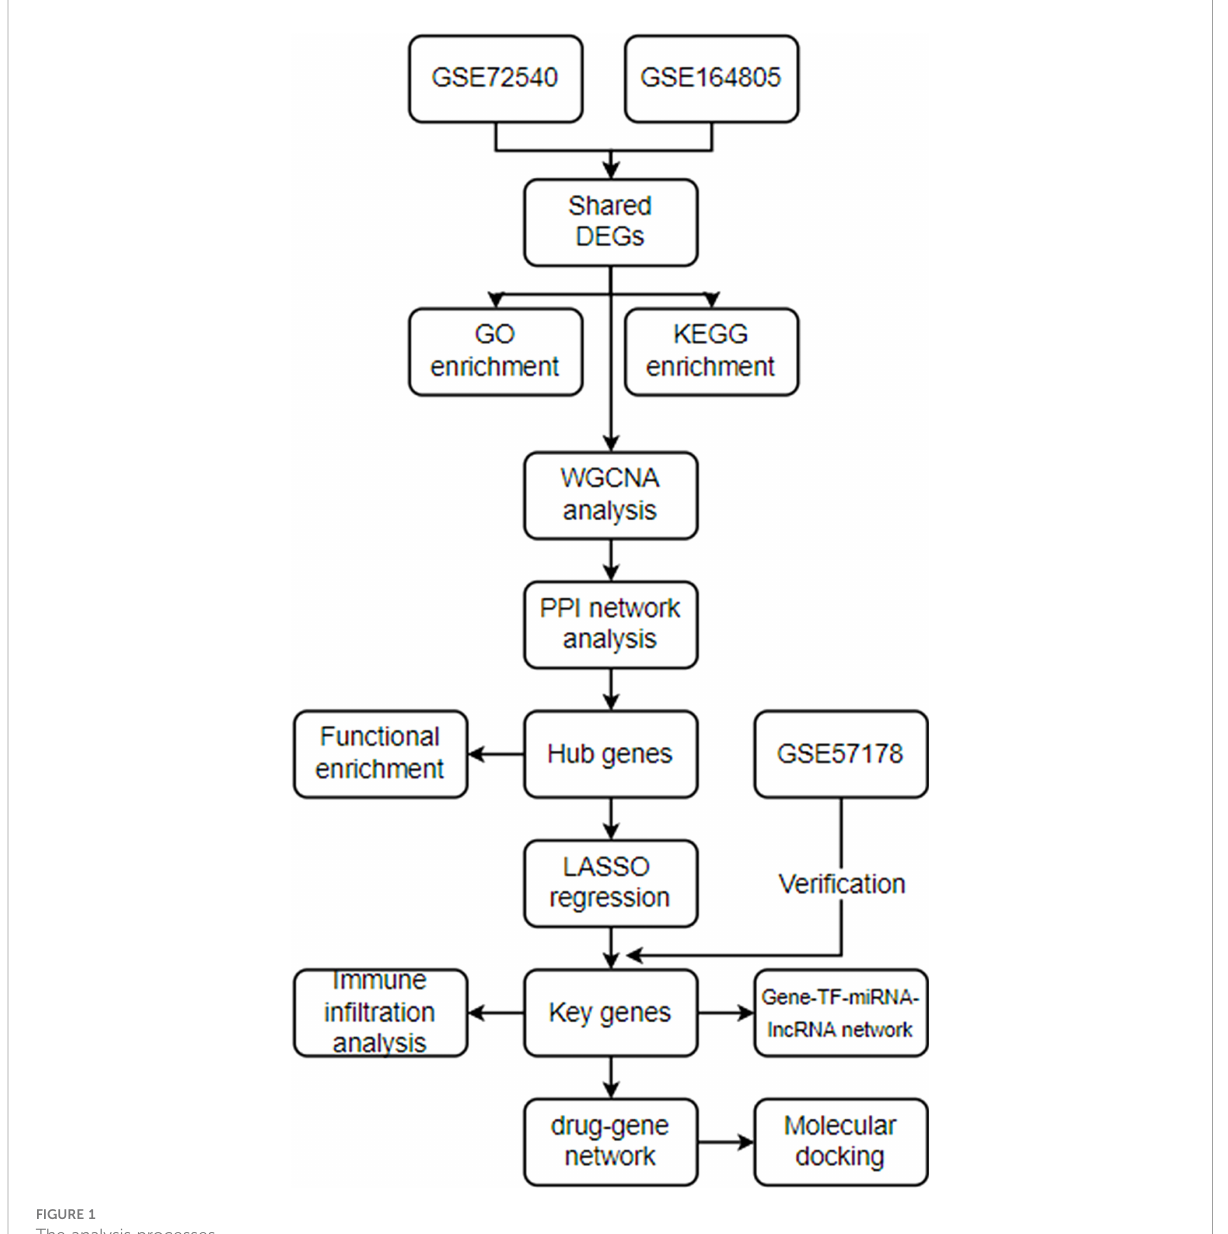
FIGURE 1 The analysis